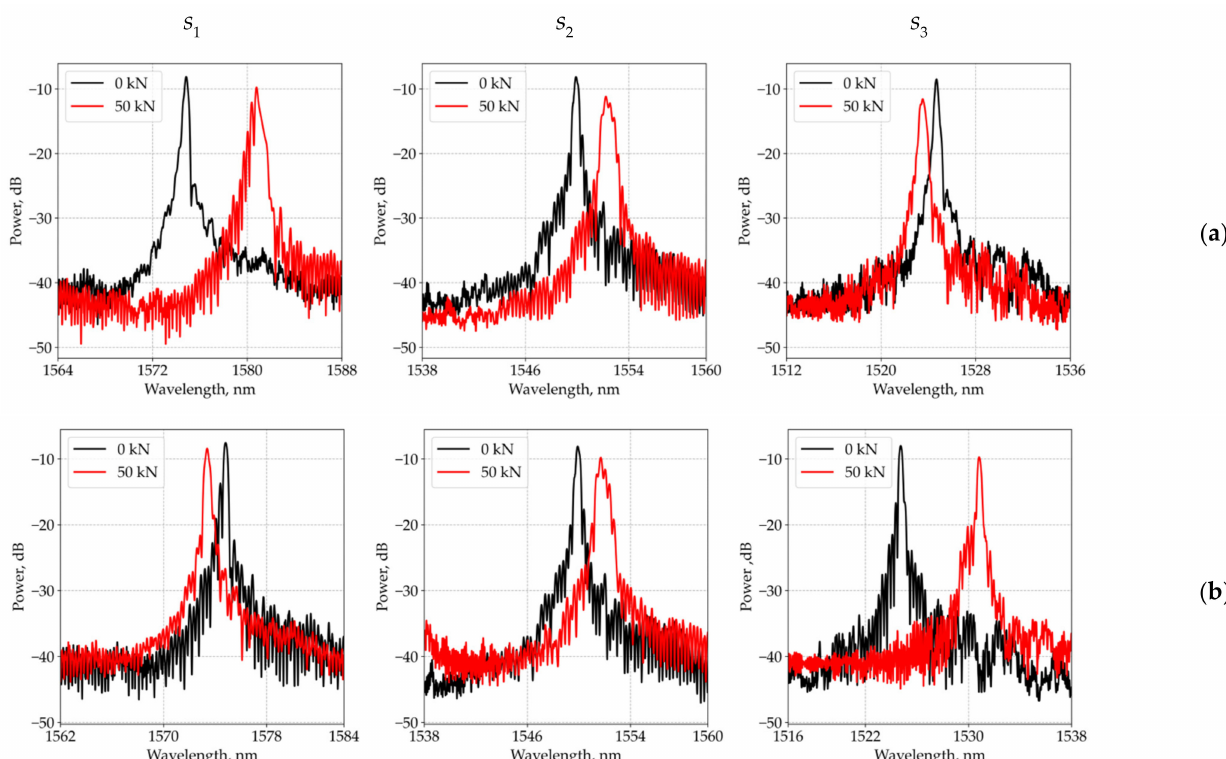
Figure 3. Reflected optical spectra in the unloaded state and under load P 0 = 50 kN in direction 1 ( a ) and direction 2 ( b